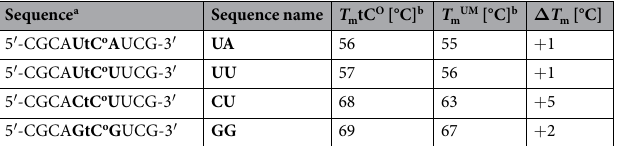
Sequence a Sequence name T m tC O [°C] b T mUM [°C] b Δ T m [°C]